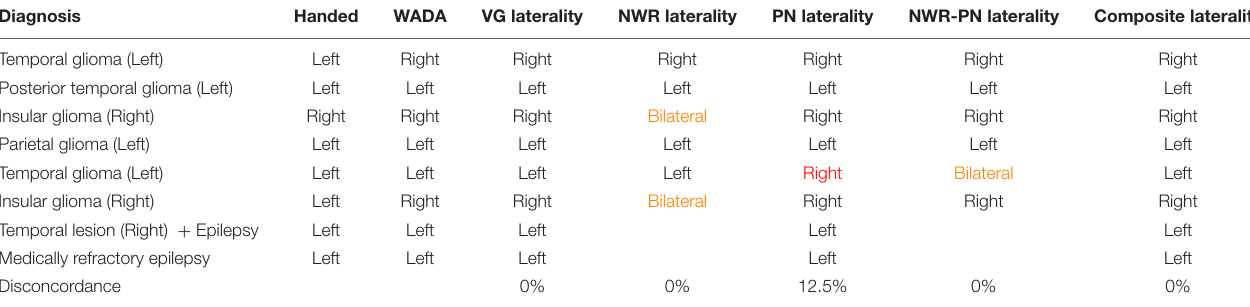
TABLE 2 | Diagnosis, handedness and laterality results for IAP, individual MEGI and composite MEGI measures in the validation group. Diagnosis